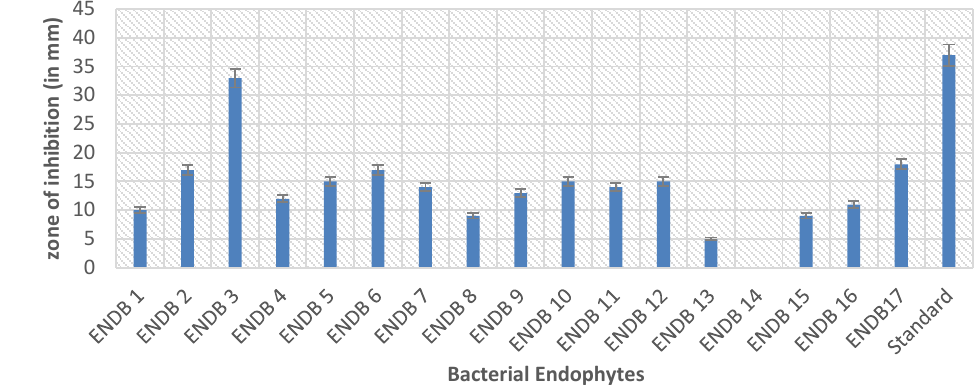
Figure 3. Antimicrobial potentiality spectra of bacterial endophytes against